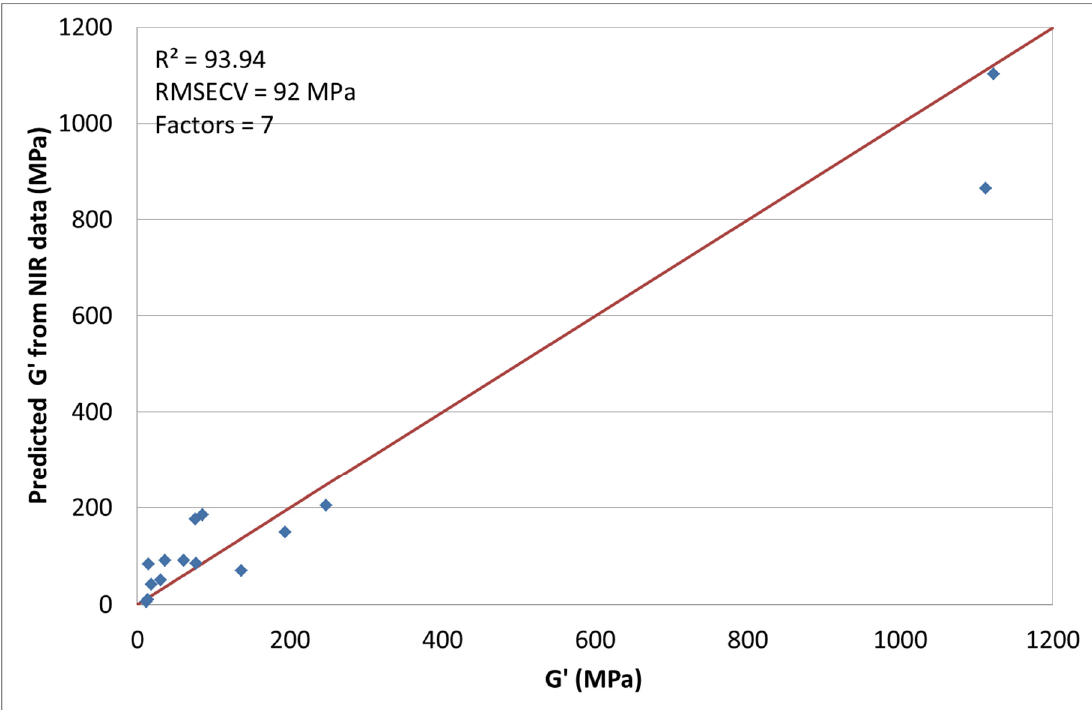
Figure 7. Predicted G’ by NIR versus measured.